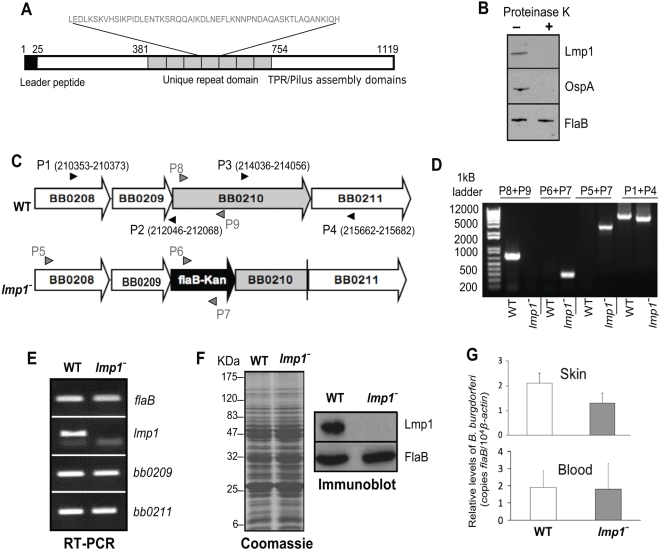
Construction and analysis of lmp1 mutant B. burgdorferi.(A) Schematic diagram representing putative domain features of the Lmp1 protein. Amino acid positions at the beginning of the putative domains are indicated on the top. The leader peptide cleavage site predicted by SignalP 3.0 [58] is located after the 25th amino acid position. The central region of the protein harbors seven unique repeat domains of 54 amino acids (indicated in gray letters), previously identified to house a potential B. burgdorferi adhesin motif [34]. The carboxyl terminal region contains putative conserved domains similar to tetratricopeptide repeat (TPR) or a pilus assembly protein, as identified by NCBI BLASTP conserved domains search program. Lmp1 sequence can be accessed via JCVI B. burgdorferi genome page with the locus tag BB_0210 or via GenBank accession number AAC66595.1 (B) Lmp1 is sensitive to proteinase K–mediated degradation of B. burgdorferi surface proteins. Viable spirochetes were incubated with (+) or without (−) proteinase K for the removal of protease-sensitive surface proteins and processed for immunoblot analysis using Lmp1 antibodies. (B) burgdorferi OspA and FlaB antibodies were utilized as controls for surface-exposed and sub-surface proteins, respectively. (C) Schematic drawings of the wild type isolate (WT) and the lmp1 mutant B. burgdorferi (lmp1−) at the bb0210 (lmp1) locus (gray box arrow). Genes bb0208, bb0209, and bb0211 (white box-arrows) and the kanamycin-resistance cassette driven by the B. burgdorferi flaB promoter (flaB-Kan, black box-arrow) are indicated. Nucleotide positions of primers P1–P4 in the B. burgdorferi genomic database (www.tigr.org) are indicated. Seven nucleotides' overlap between the end of bb0209 and the start of bb0210 was not deleted in the allelic exchange by extending the primer P2 until the end of bb0209. The 5′ and the 3′ arms for homologous recombination flanking upstream and downstream of the lmp1 locus were amplified using primers P1–P2 and P3–P4 (black arrowheads), and ligated to the flaB-Kan cassette as detailed in Materials and Methods. (D) Integration of the mutagenic construct, flaB-Kan, in the intended genomic locus. Primers 5–9 (gray arrowheads, positions indicated in Figure 2C) were used for PCR analysis with isolated DNA from wild type or lmp1 mutant B. burgdorferi as templates. (E) RT-PCR analysis of wild type or lmp1 mutant B. burgdorferi. Total RNA was isolated from cultured spirochete, and transcript levels of lmp1, flaB, bb0209, and bb0211 were detected by RT-PCR analysis. (F) The lysates of wild type and lmp1 mutant B. burgdorferi were separated on a SDS-PAGE gel and either stained with Coomassie blue (left) or transferred onto a nitrocellulose membrane and probed with the antiserum against Lmp1 or FlaB (right). Migration of protein standards is shown to the left in kDa. (G) The lmp1 mutant B. burgdorferi were capable of dissemination from the dermis of infected mice. Skin and blood samples were collected from mice seven days after challenge, and the B. burgdorferi load was analyzed by quantitative PCR measurement of flaB copies and presented as flaB/murine β-actin.